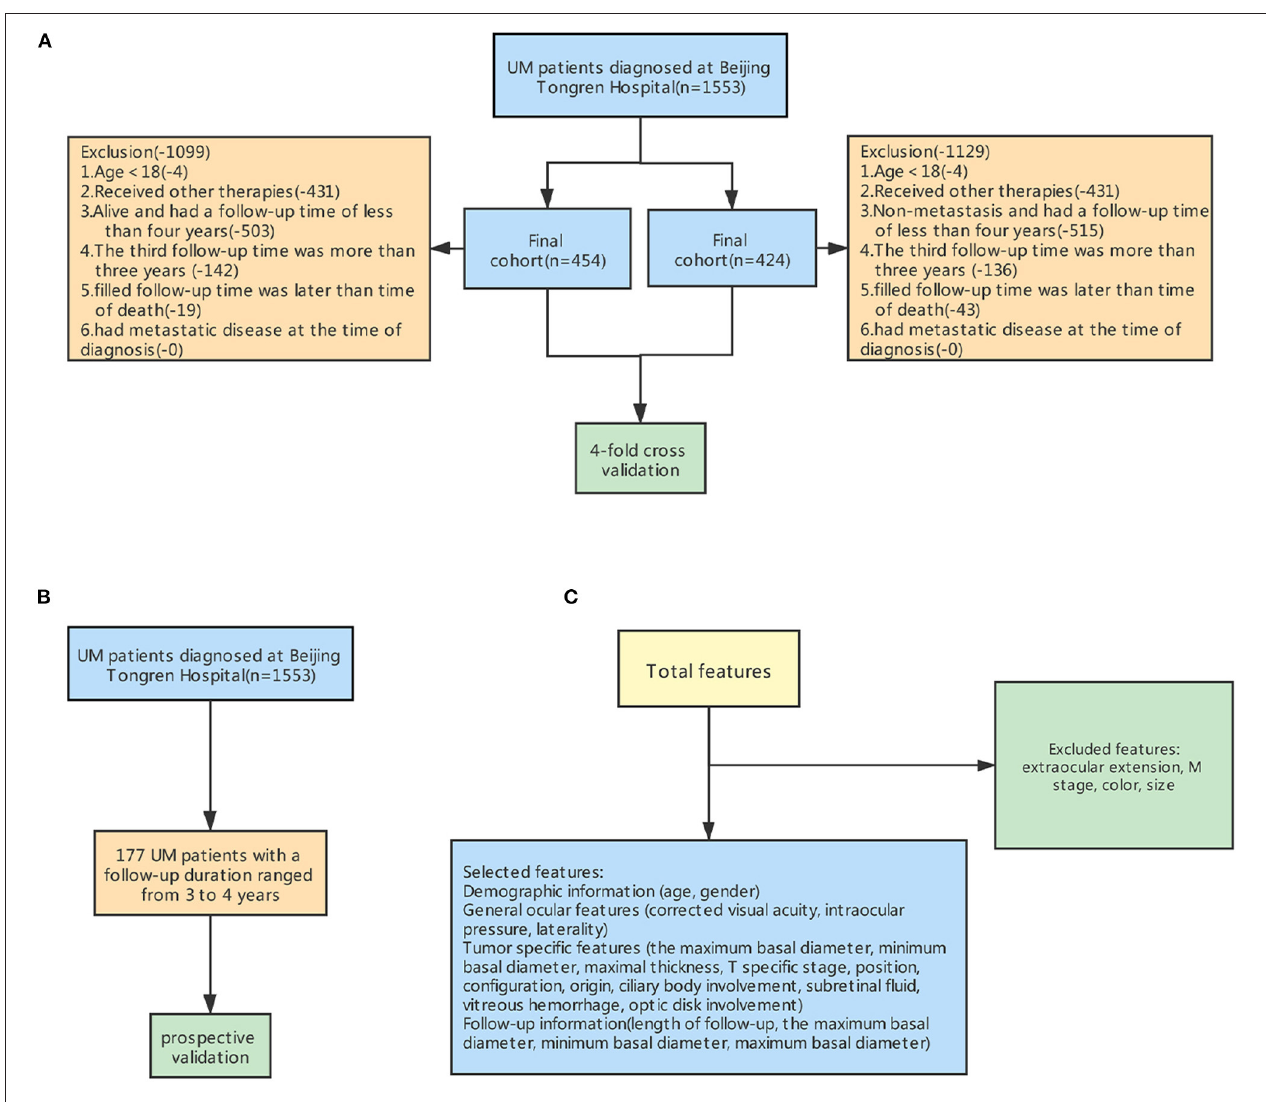
FIGURE 2 | Steps for excluding features and samples to preprocess the input dataset for machine learning. (A) The workflow for excluding some samples. (B) Prospective validation (C) The workflow for excluding some